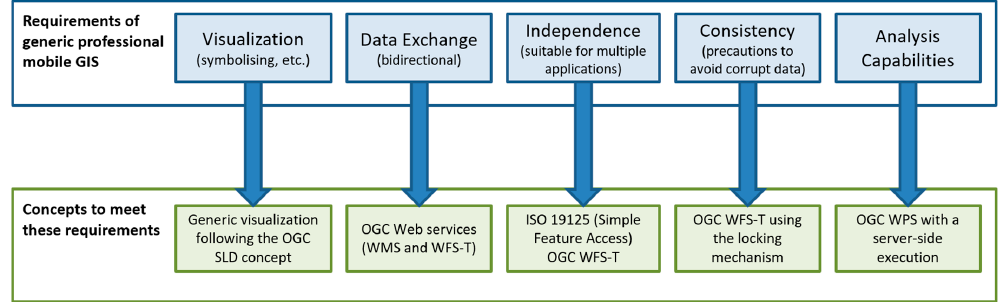
Figure 2. Requirements of generic and professional mobile GIS.